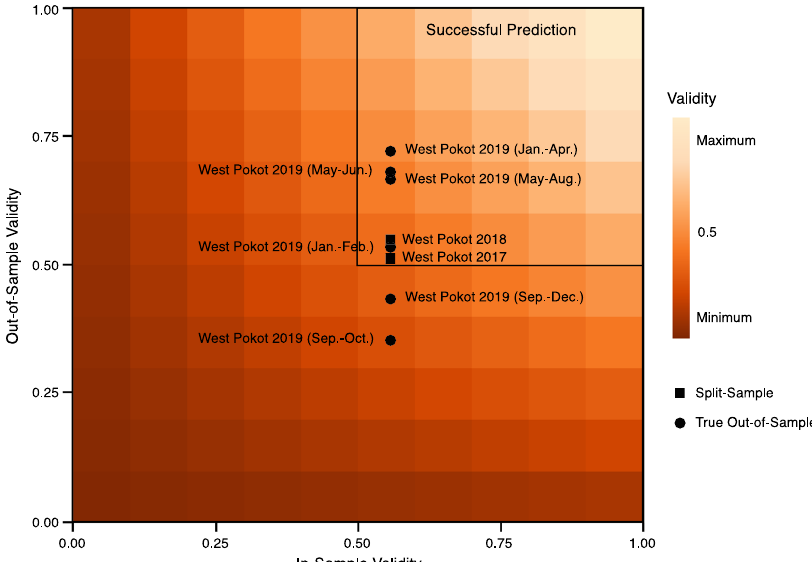
Fig. 5 West Pokot: joint validity scale. Simulations with both high in- and out-of-sample validity, measured by F1, are located in the upper-right hand